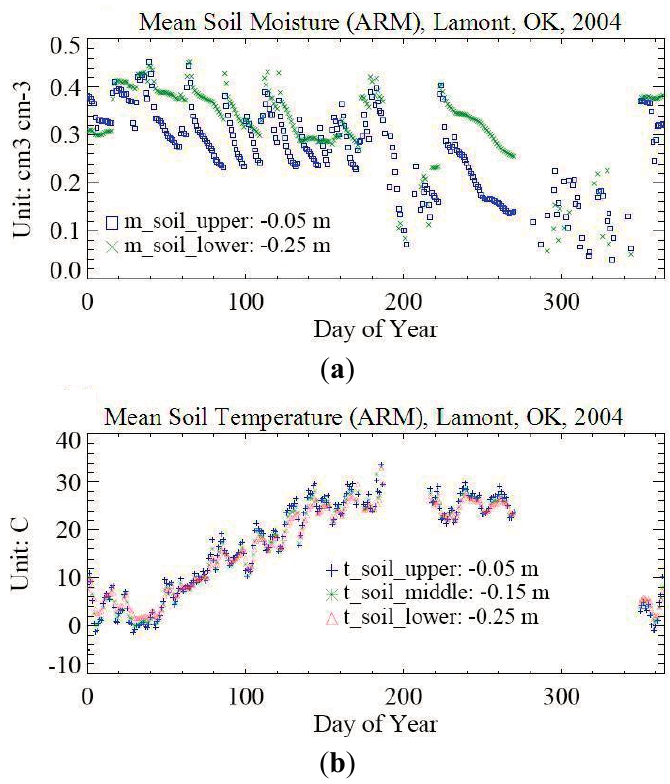
Figure 2. ( a ) Annual variations of daily averaged soil moisture at upper layer ( − 0.05 m) and lower layer ( − 0.25 m). ( b ) Annual variation of daily averaged soil temperature for upper soil